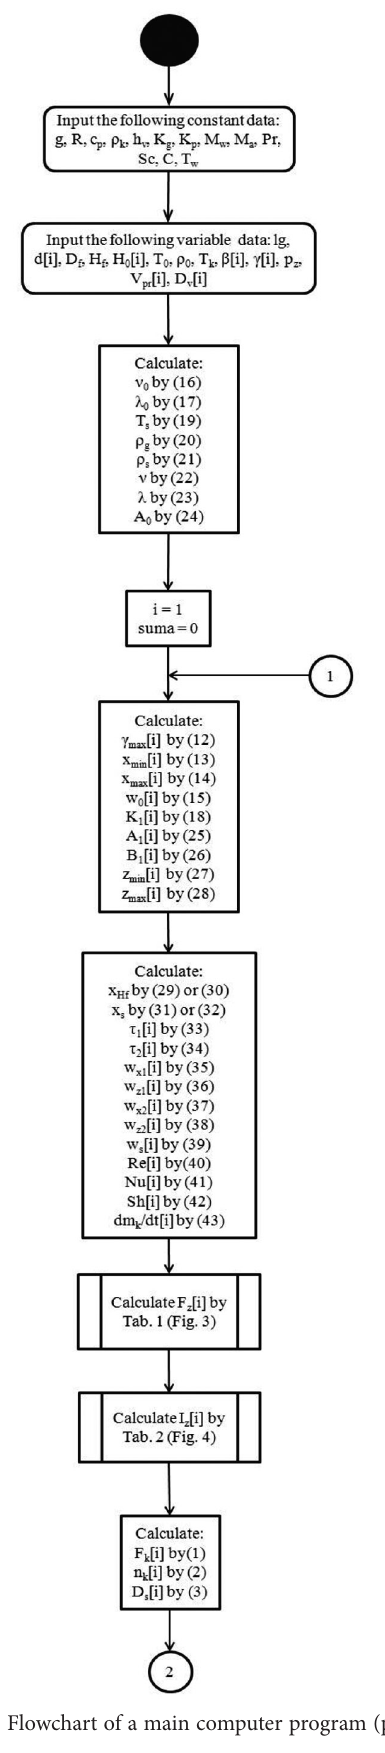
Figure 2. Flowchart of a main computer program (part 1)